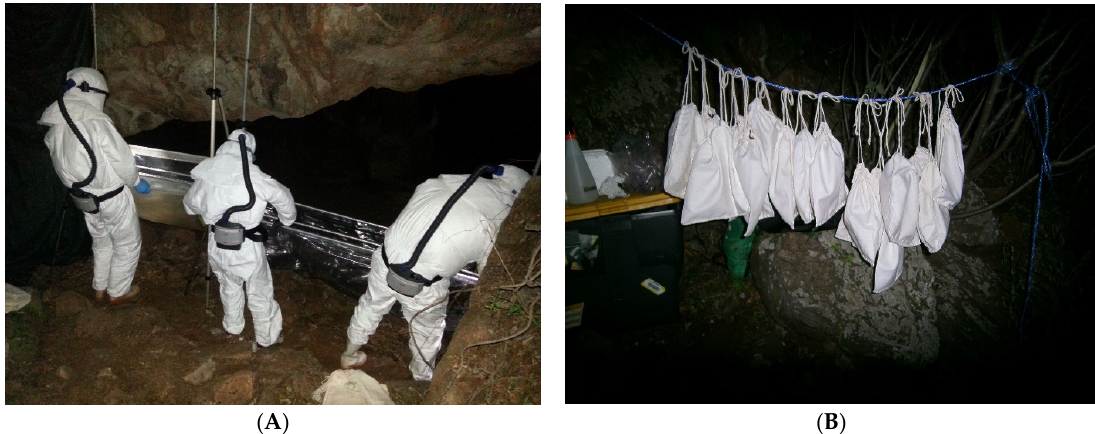
Figure 3. Collecting of bats trapped in harp traps by operators dressed in BSL3 personal protective equipment at the entrance to Matlapitsi cave, Matlapitsi Valley, Limpopo province, South Africa ( A ); Captured R. aegyptiacus placed in individual cotton bags until sampling ( B ).